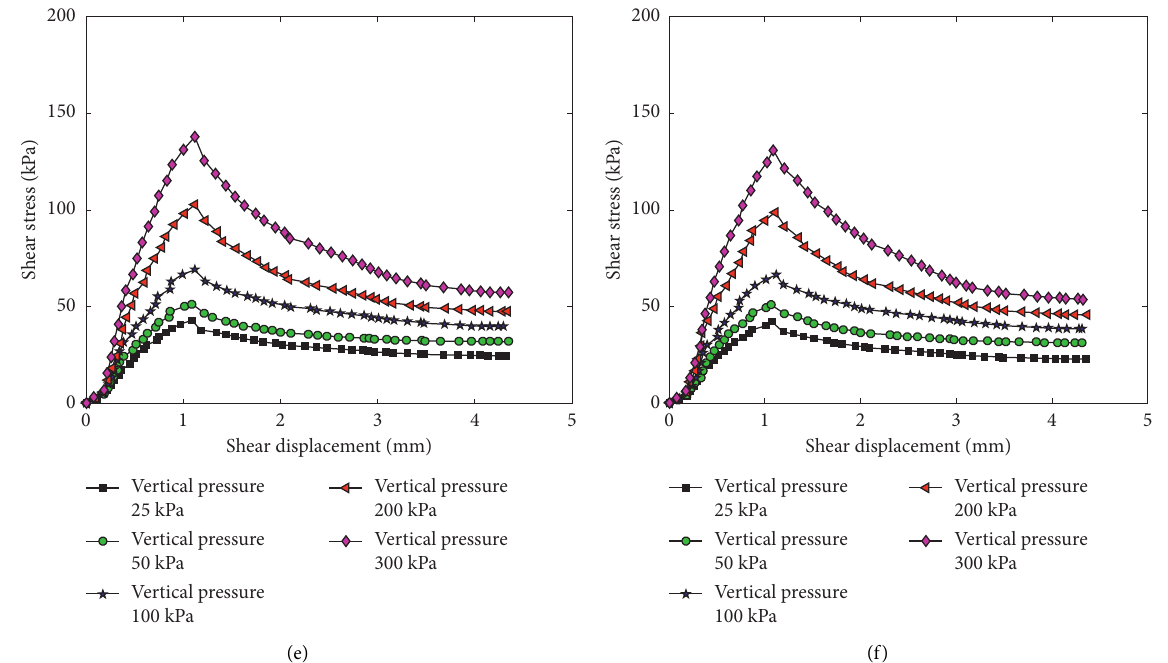
Figure 3: Shear stress-displacement curves after wetting-drying cycles: (a) zeroth cycle; (b) first cycle; (c) second cycle; (d) third cycle; (e) fourth cycle; (f) fifth